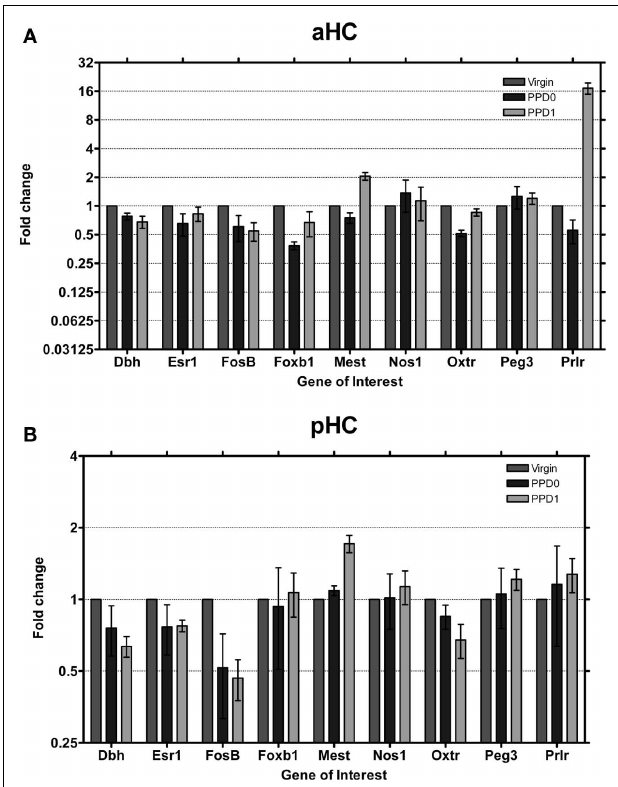
FIGURE 6 | Changes in fold expression (determined by C T method) at PPD0 and PPD1 in the (A) aHC and (B) pHC. Mean ± SD are plotted on a log2 scale, such that fold increases and decreases are represented